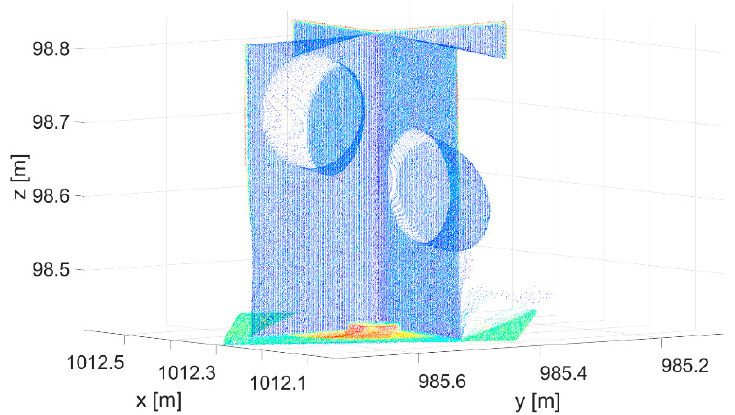
Figure 3. Input point cloud of the target.